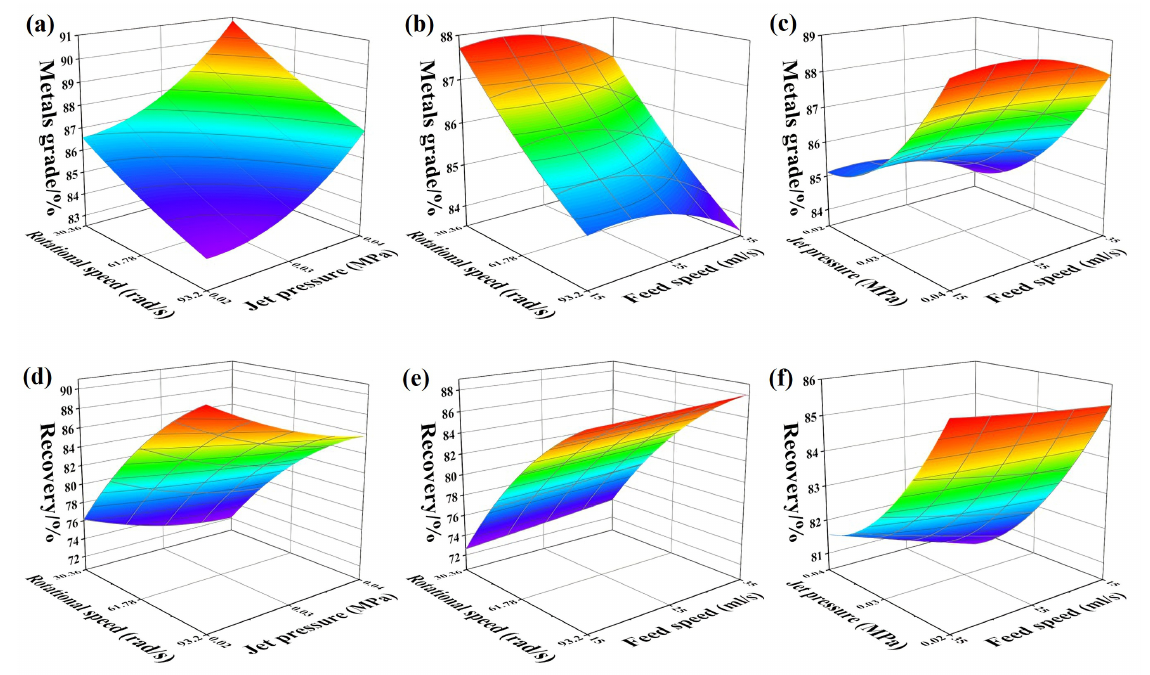
Figure 5. The response surfaces of the experimental factors of centrifugal separation. The relationship between metals grade and test conditions was shown in ( a – c ); and the relationship between recovery and test conditions was shown in ( d – f ).